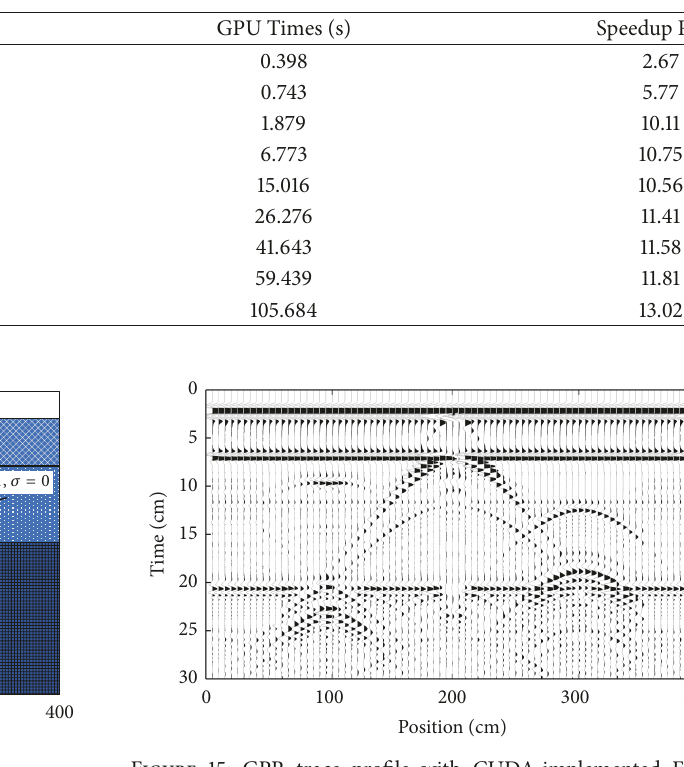
Figure 13: Schematic diagram of a two-layer pavement model with no-dense region.